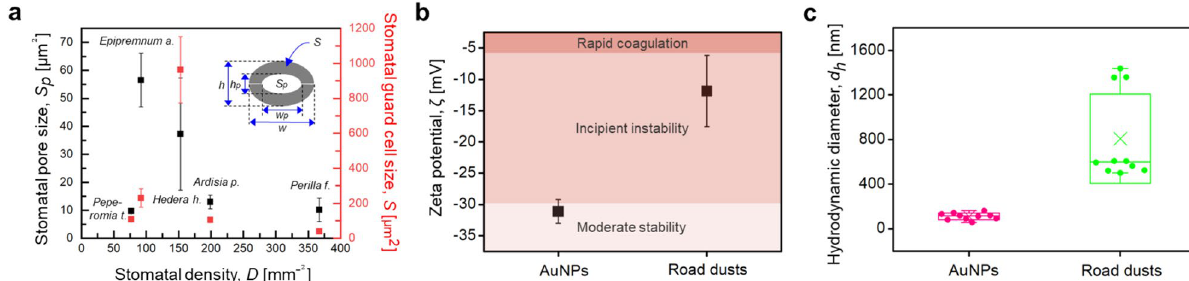
Figure 3. Geometrical/chemical features of stomata and AuNPs related to the absorption of PM particles through stomatal openings. ( a ) Comparison of stomatal guard cell size ( S ) and stomatal pore size ( S p ) versus stomatal number density ( D ) of P. frutescens and four air-purifying plant species, Peperomia t. , Epipremnum a. , Hedera h. , and Ardisia p. An inset describes the stomatal dimensions. By assuming elliptical-shaped stomata, S p , h p , and w p indicate the size, minor axis, and major axis of the elliptical stomatal pore, respectively, while S , h , and w represent those of stomatal guard cells. Stomatal number density ( D ) indicates the number of stomata per unit area. ( b ) Zeta potential ( ζ ) and ( c ) hydrodynamic diameter ( d h ) of AuNPs and road dusts. The ζ values of AuNPs and road dusts support that AuNPs are moderately stable, while road dusts (solid PM 2.5 particles) are incipiently instable. The d h values of AuNPs are much smaller than those of road dusts. Error bars indicate standard deviations (SD).